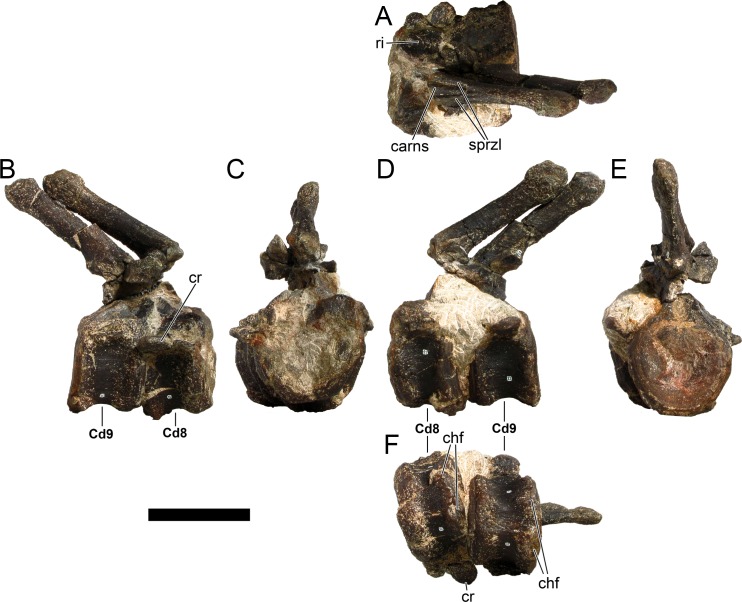
Caudal vertebrae eight and nine of Miragaia longicollum MG 4863.A, dorsal, B, right lateral, C, anterior, D, left lateral, E, posterior, and F, ventral view. Cd8, caudal vertebra eight, Cd9, caudal vertebra nine, carns, central anterior ridge of neural spine, chf, chevron, ri, ridge, sprzl, spinoprezygapophyseal lamina. Scale bar equal to 10 cm.